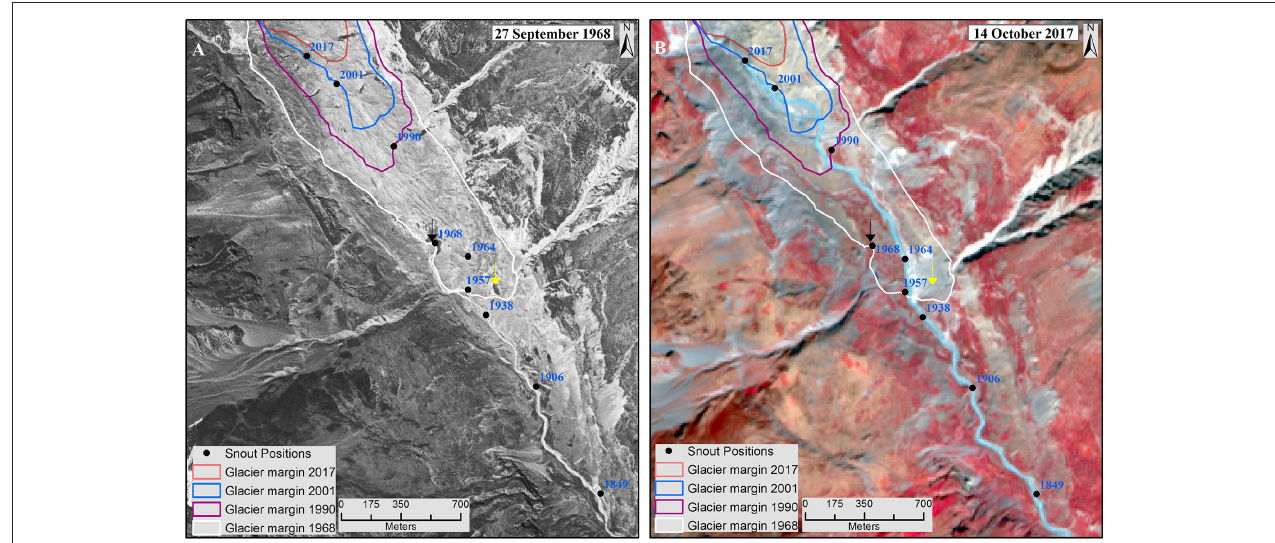
FIGURE 2 | Recession of the Milam glacier and associated morphological changes. The glacier extents derived from different satellite images for 1968, 1990, 2001, and 2017 are overlaid on Corona (A) and Sentinel 2 image (B) . The terminus positions of the Milam glacier for 1906, 1938, 1957, and 1964 are based on Cotter and Brown (1907), Mason (1939) Jangpangi (1975), and Kumar et al. (1975), respectively, while those for 1968, 1990, 2001, and 2017 are from Corona (1968), Landsat TM (1990), ETM + (2001), and Sentinel 2 (2017), respectively. The glacier terminus of 1849 was extrapolated from the terminus position of 1906 ( Cotter and Brown, 1907) along the flow line of Gori Ganga river. The prominent and smaller glacier terminus observed on Corona image of 1968 have been marked with black and yellow inverted arrows, respectively.